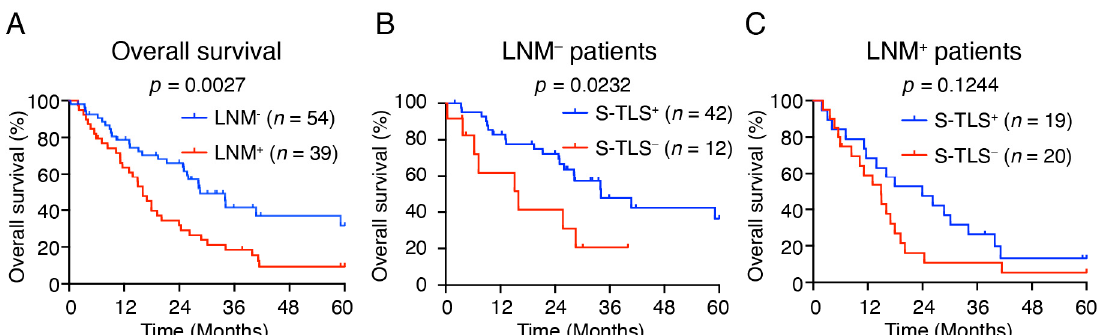
Figure 4. The relationship between S-TLS and Lymph node metastasis. ( A ) Kaplan–Meier curves show the comparison of OS in patients with pCCA according to the presence or absence of lymph node metastasis. ( B , C ) Kaplan–Meier curves show the comparison of OS in pCCA patients with or without lymph node metastasis according to the presence or absence of S-TLSs.